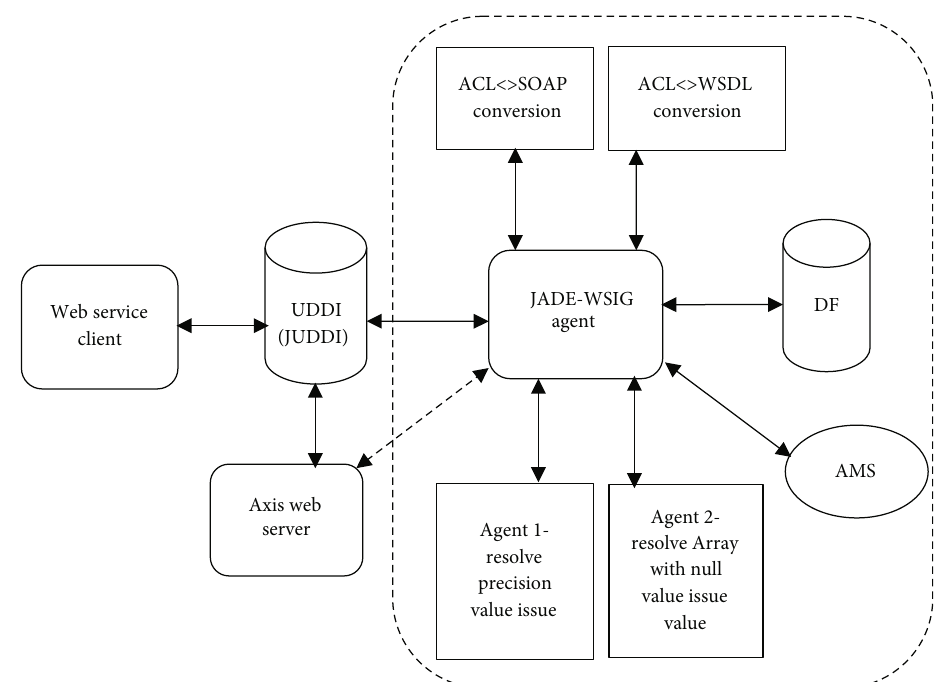
Figure 13: An architecture of JADE-WSIG using the multiagent